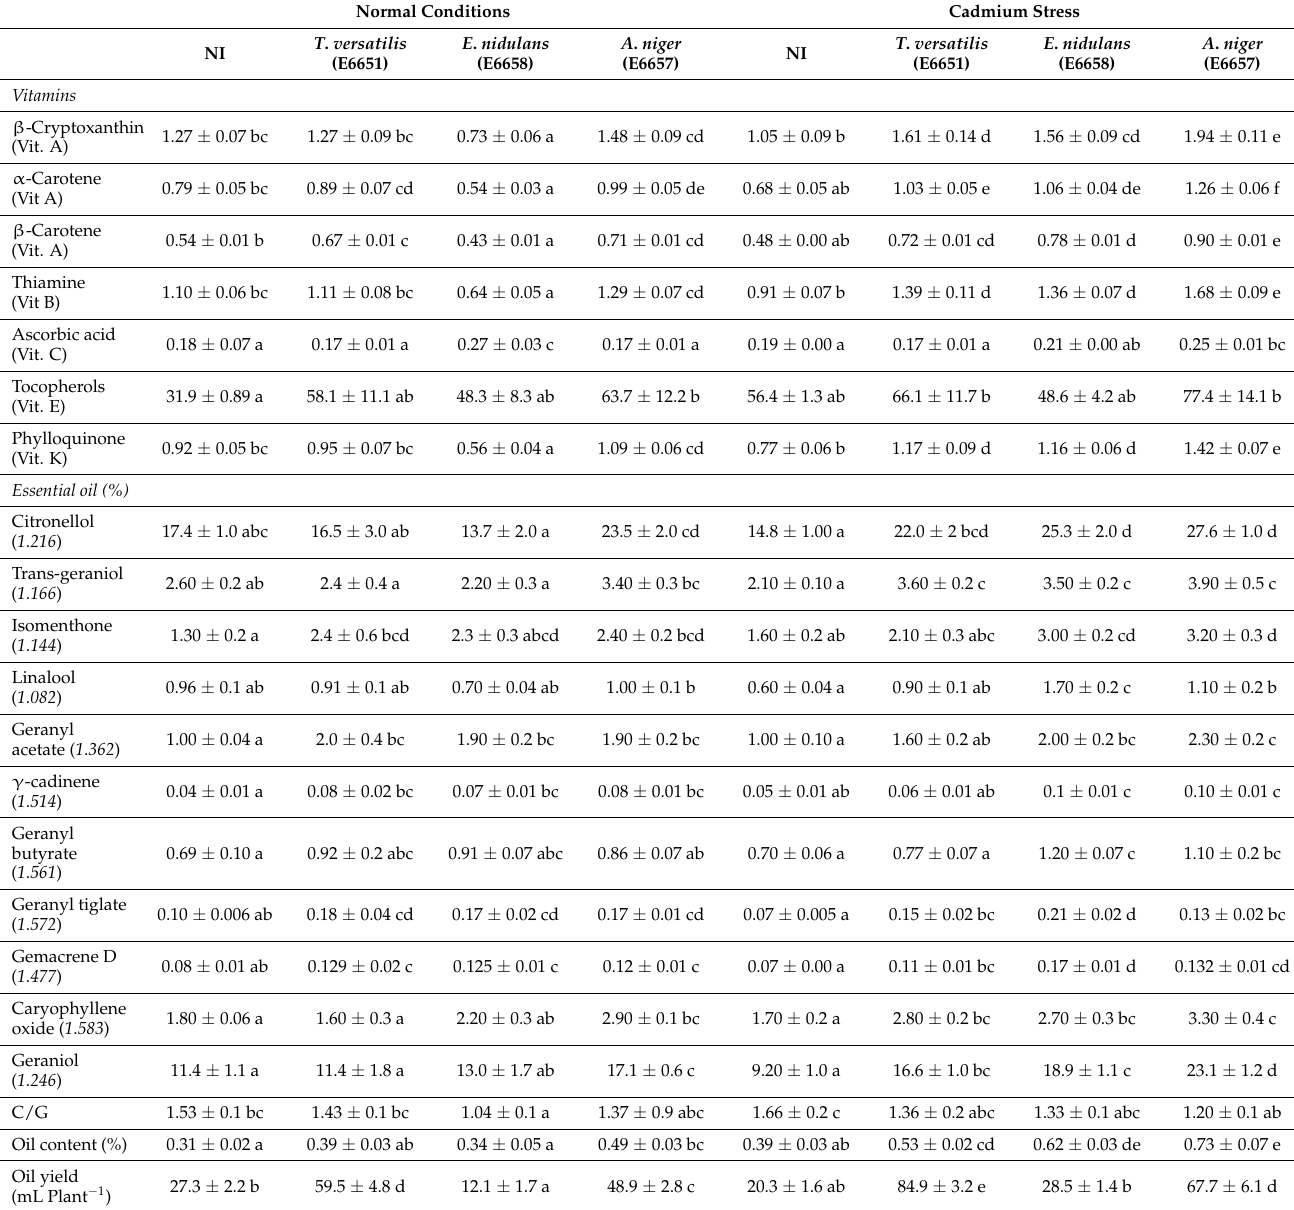
Table 2. Vitamin content, essential oil chemical constituents (%), oil content (%), and oil yield (mL Plant − 1 ) of gera- nium leaves in response to inoculation with endophytic fungi under normal conditions and Cd-stress; after 17 days of applying